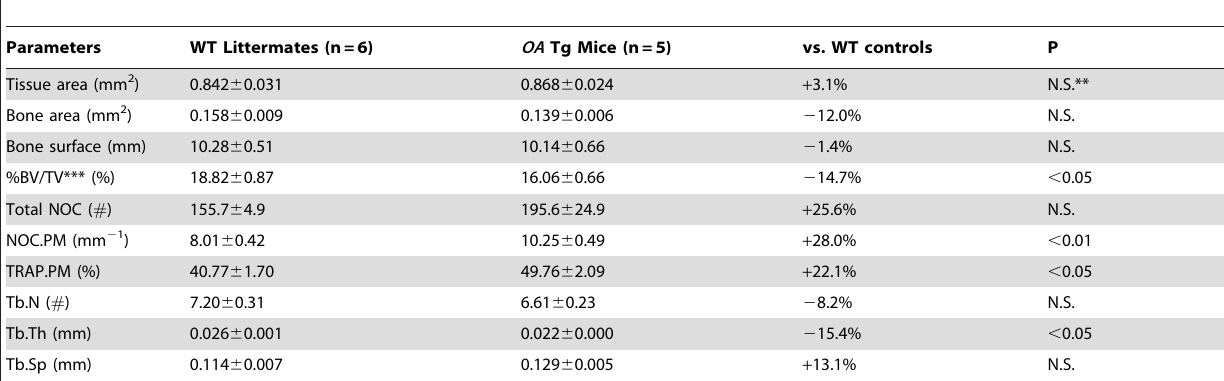
Table 3. Comparison of static histomorphometric trabecular bone parameters at the secondary spongiosa of 4-week-old female OA -Tg mice with age- and sex-matched WT littermates (mean 6 SEM).*